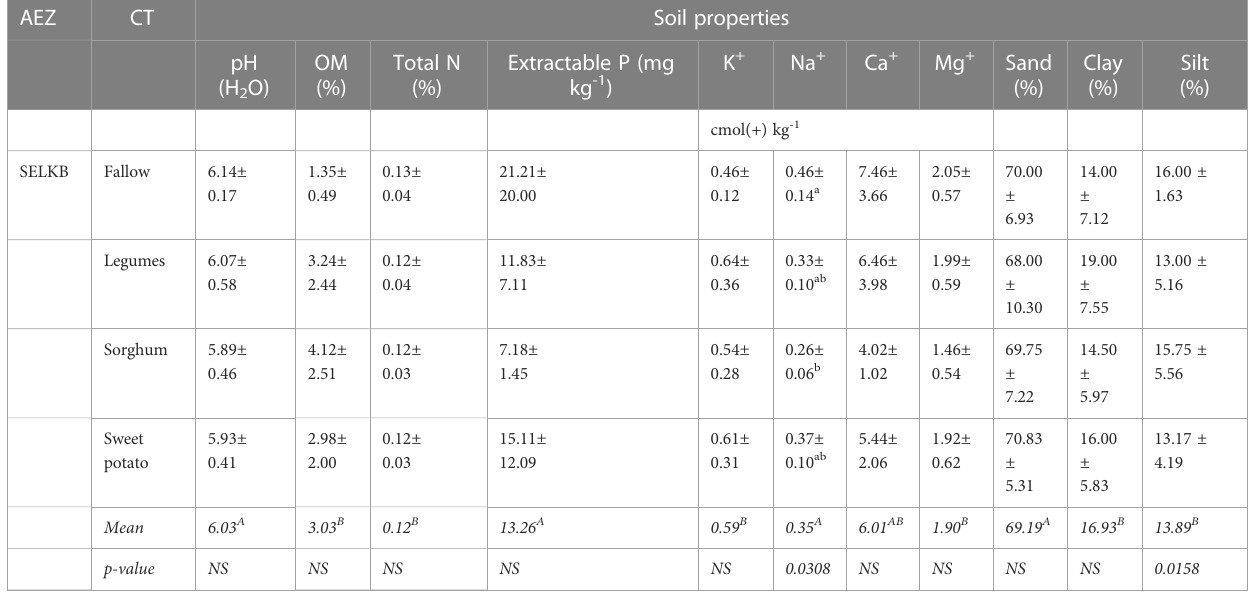
TABLE 5 Selected soil physical and chemical properties across three AEZs and four CTs. AEZ CT